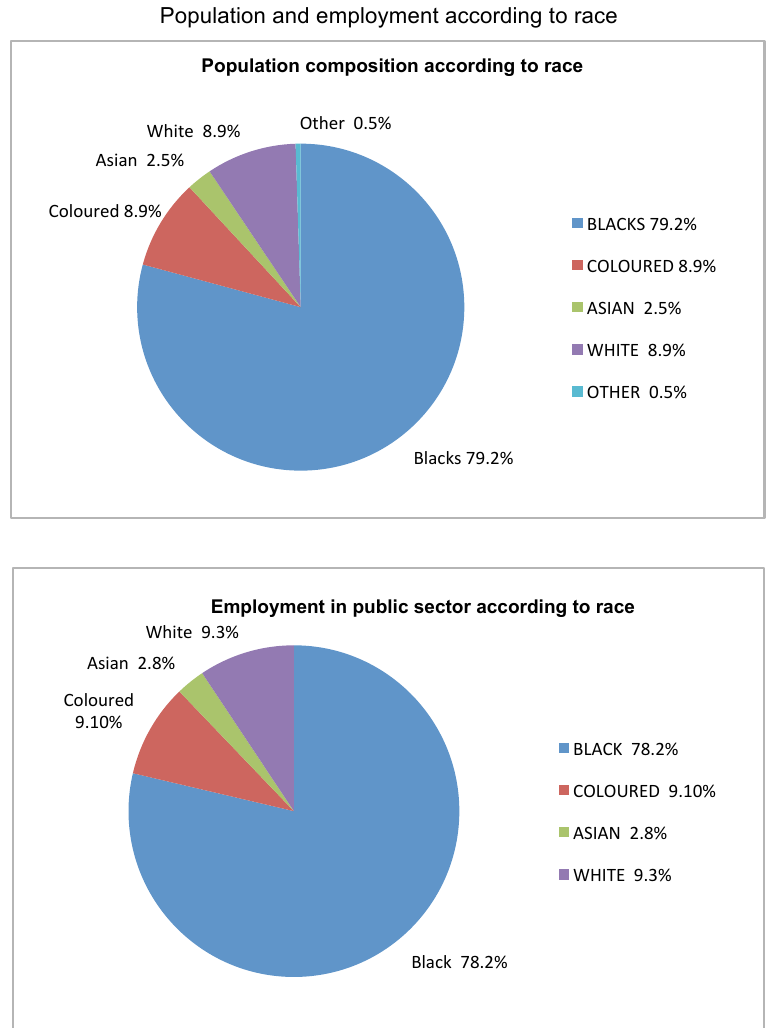
Population and employment according to